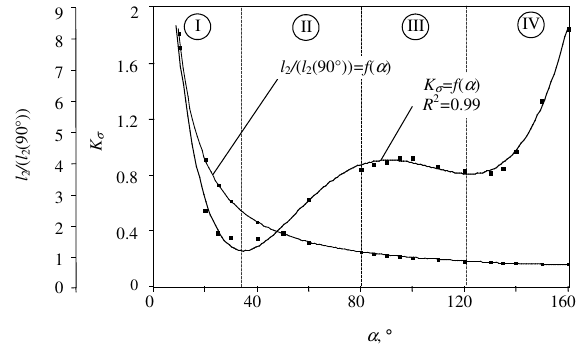
Fig 4. Relationship of stress concentration factor K σ and the ratio l 2 /( l 2 (90°)) with respect to angle between edges α ; R 2 is determination factor